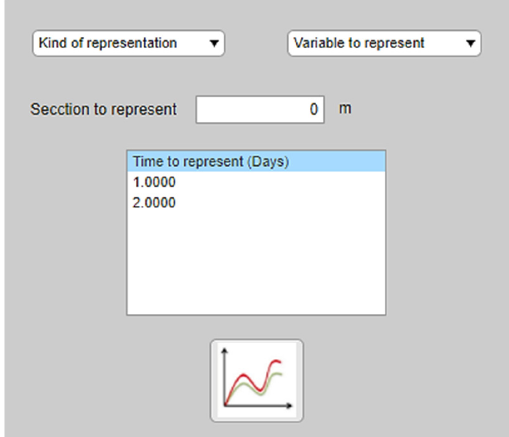
Figure 12. Screen to accesses the graphical solutions.